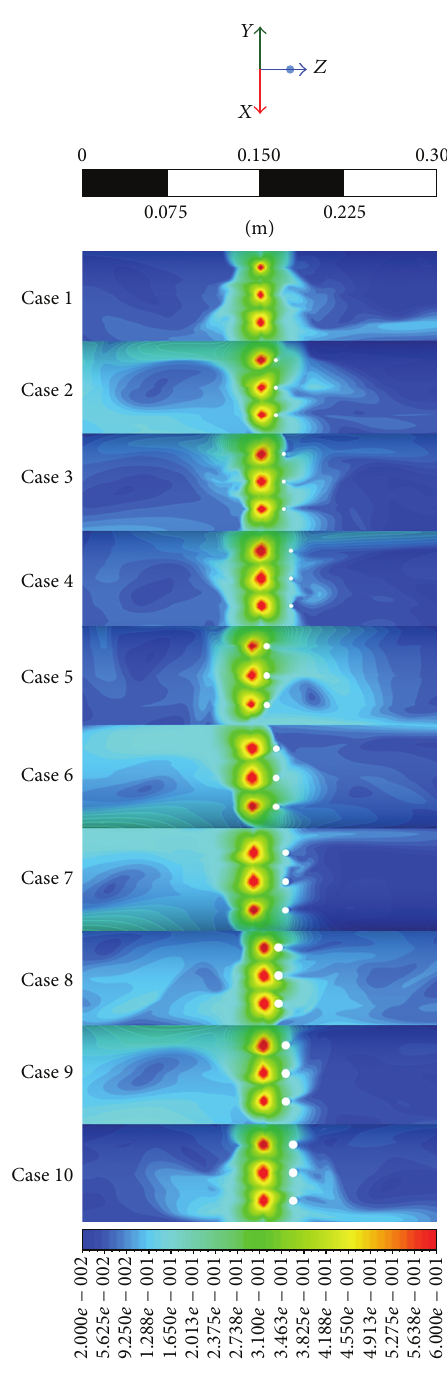
Figure 6: Contours of cooling